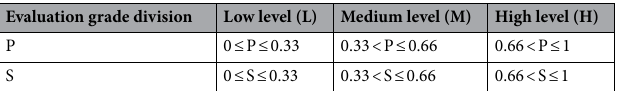
Table 3. Evaluation grade classification of support surface and pressure surface.